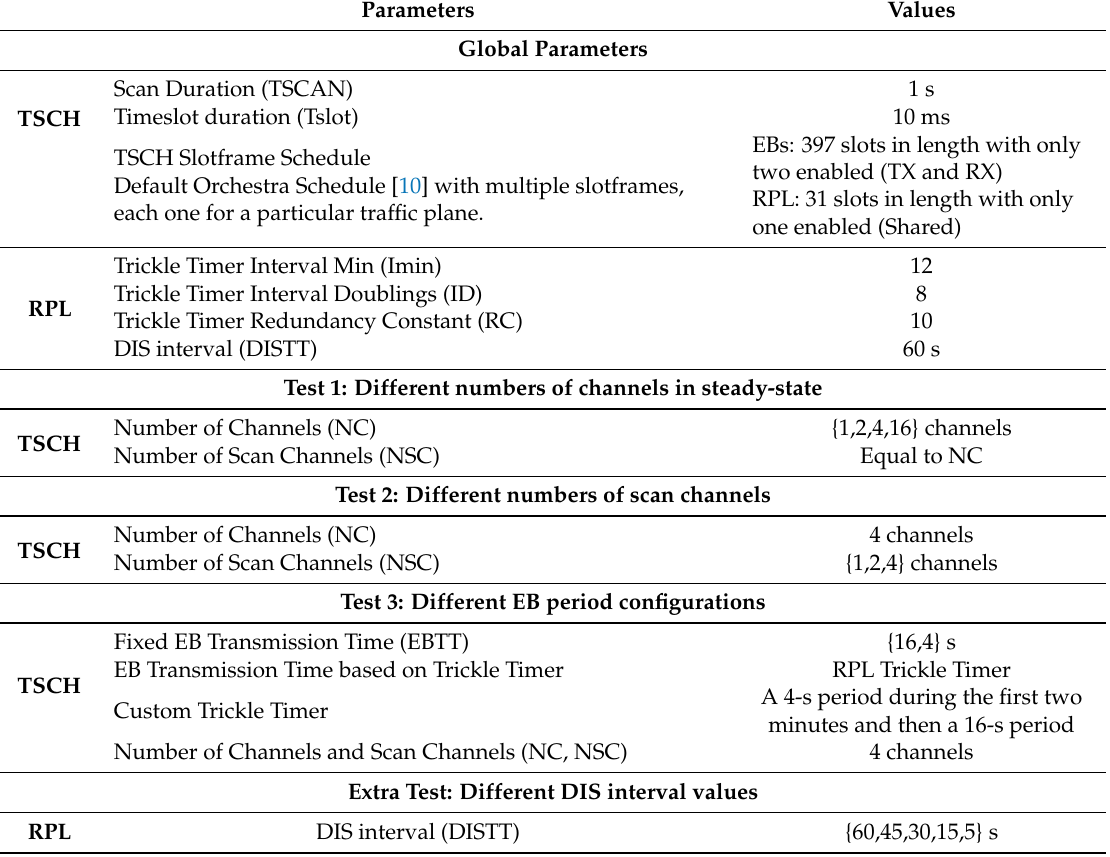
Table 2. The configuration parameters that were simulated during the experiments. Parameters Values Global